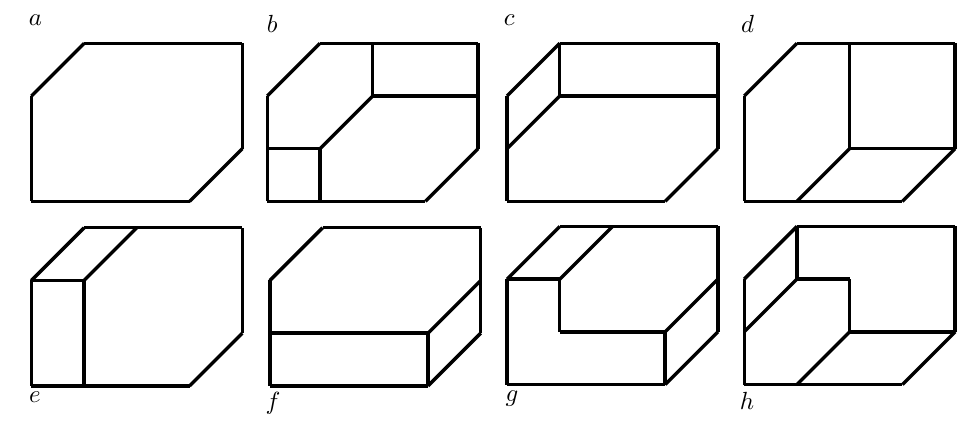
Figure 14 . TCMDs of Q , associated to the faces of N 2 ; 2